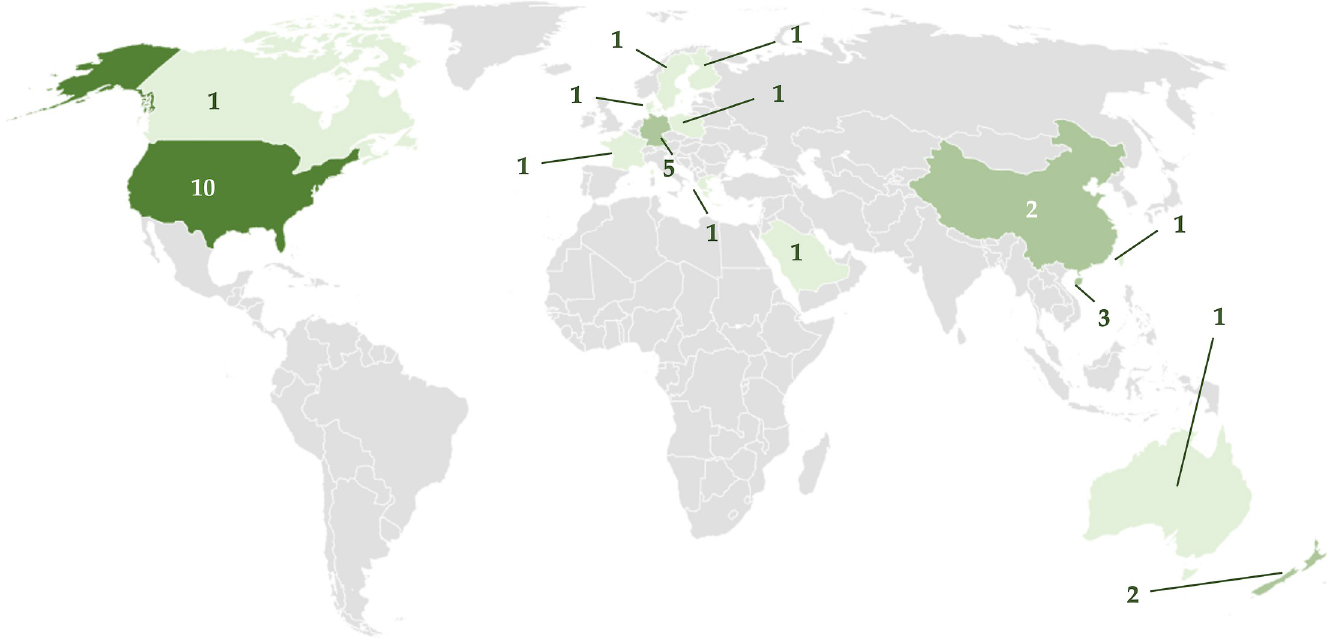
Fig 2. Geographical distribution (country of origin) of the selected studies (number of studies per